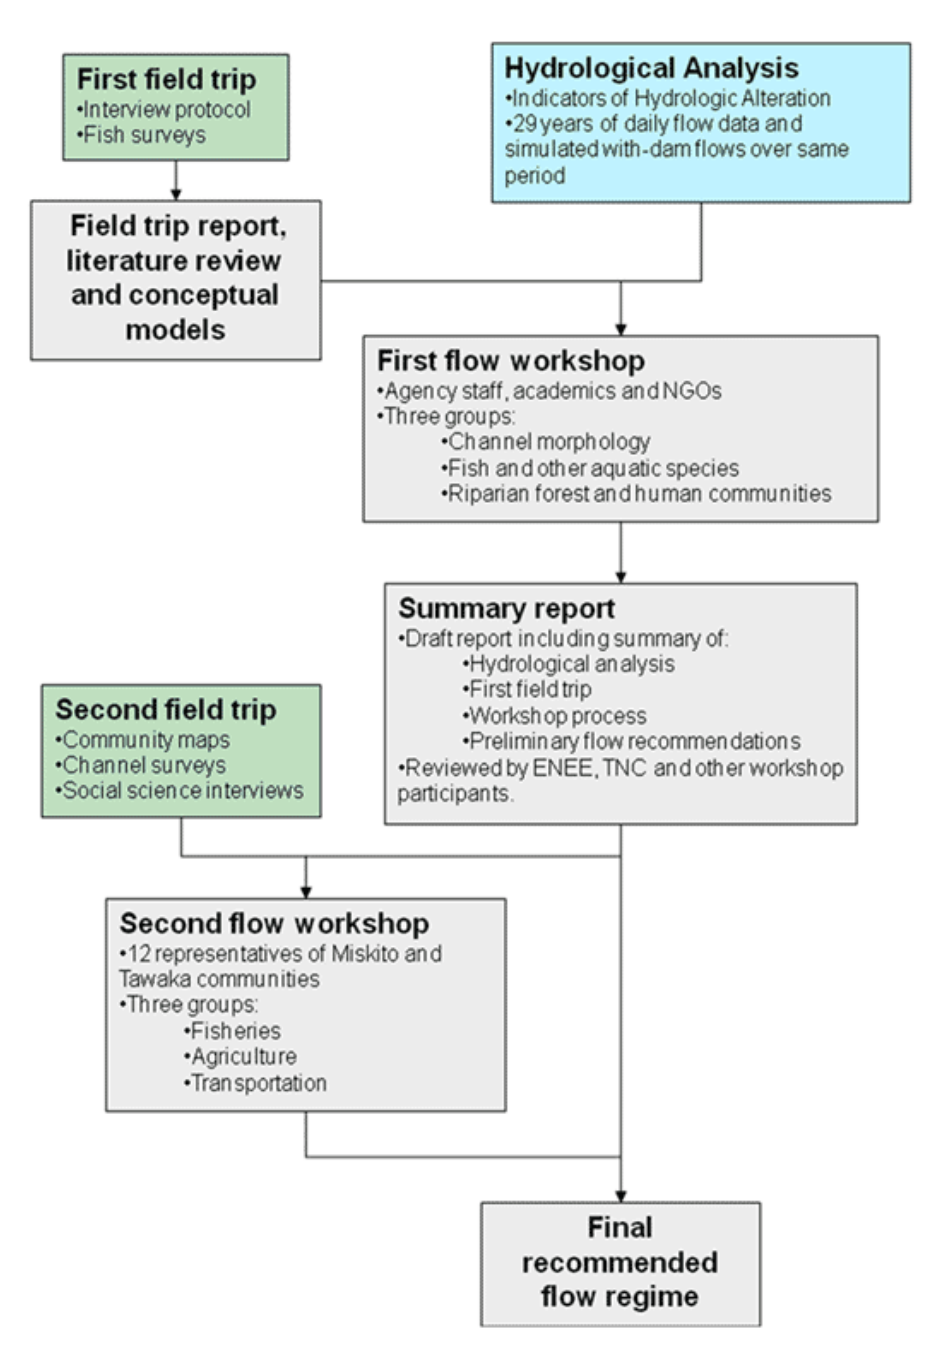
Fig. 3. Flow chart showing process used in this study to prescribe an environmental flow regime for the Patuca